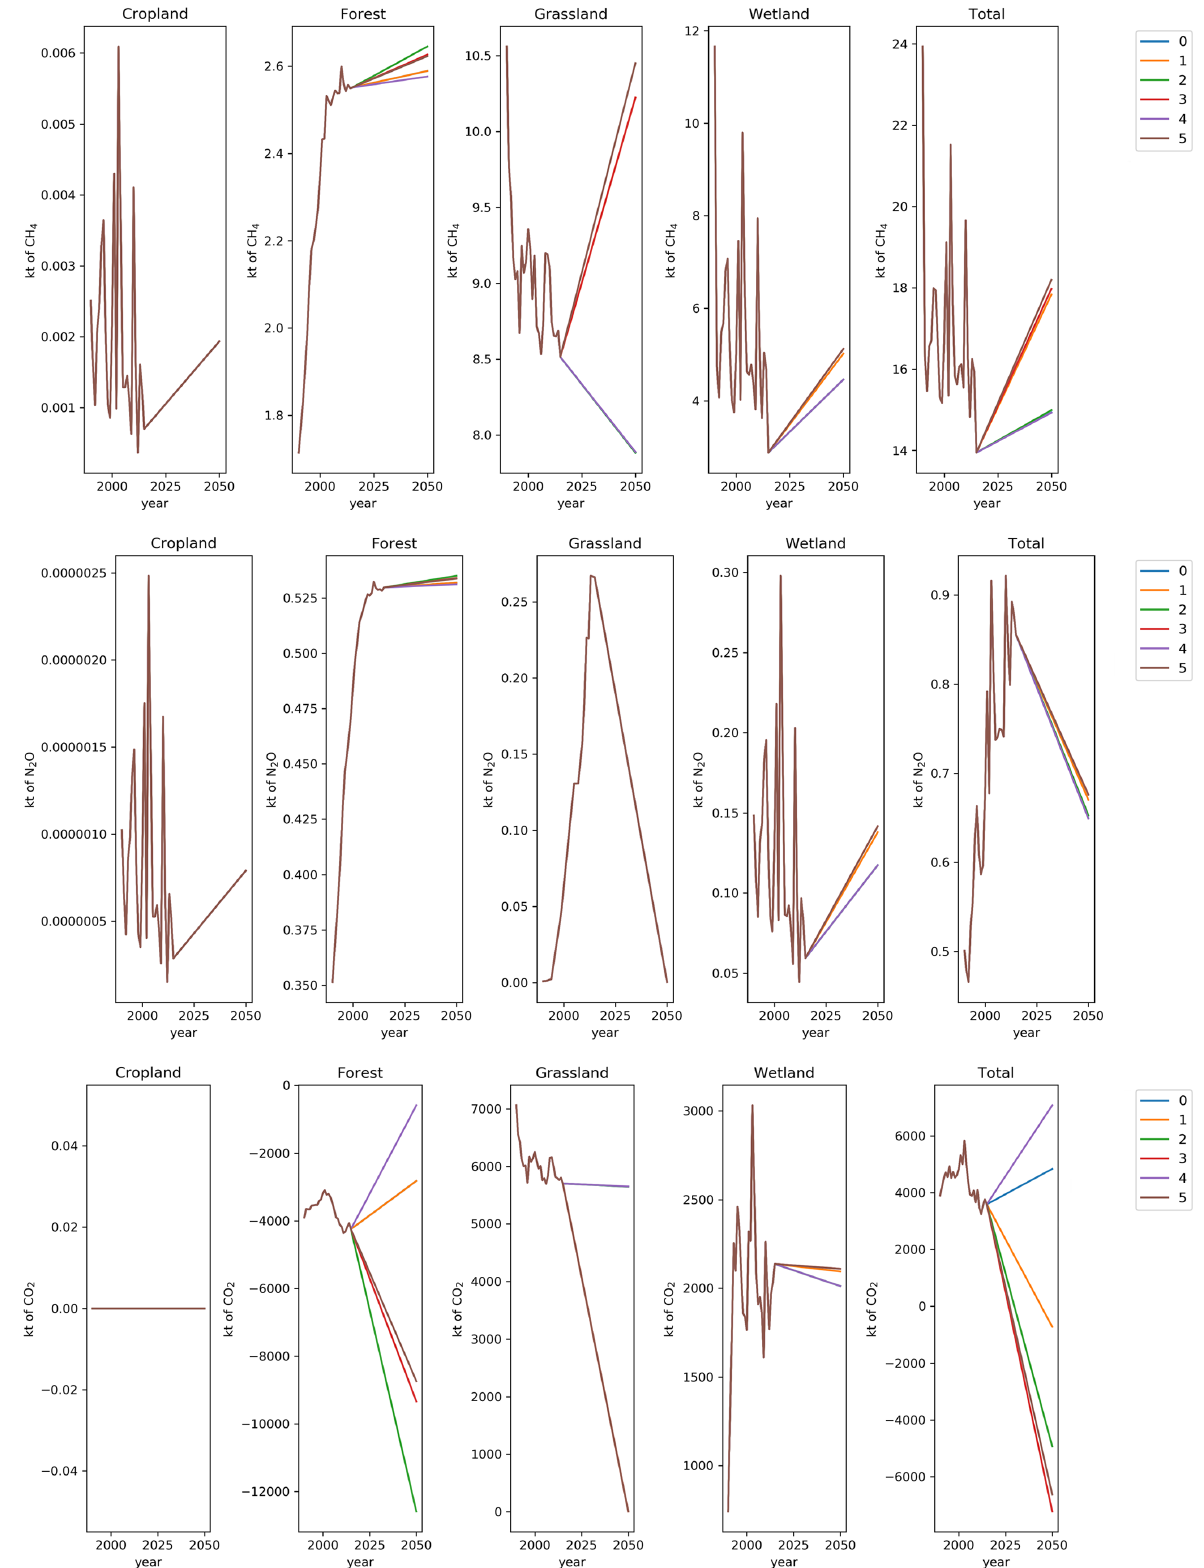
Figure 10. Summary of agricultural CH 4 , N 2 O, and CO 2 fluxes across cropland, forest, grassland, and wetland land uses.